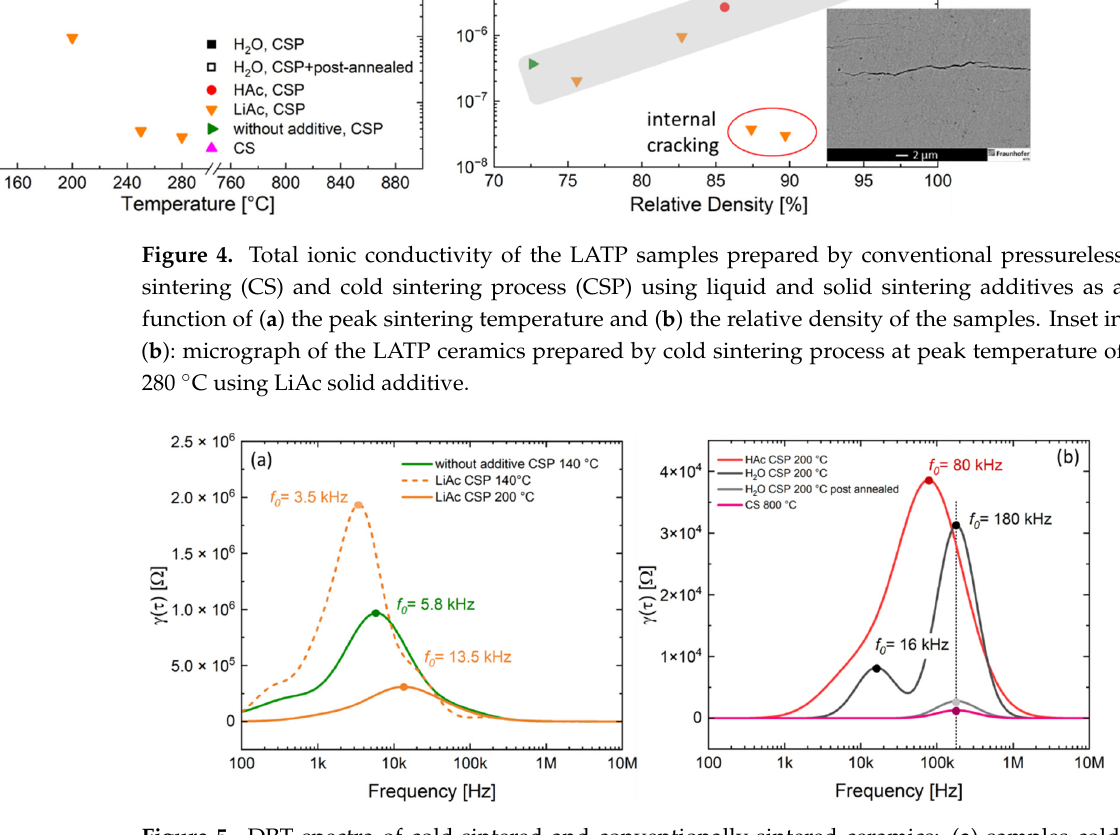
Figure 5. DRT spectra of cold-sintered and conventionally-sintered ceramics: ( a ) samples cold-sin- tered without additives at 140 °C and with LiAc at 140 and 200 °C, ( b ) samples cold-sintered with H 2 O and HAc at 200 °C as well as post-annealed and conventionally-sintered ones (both 800 °C).